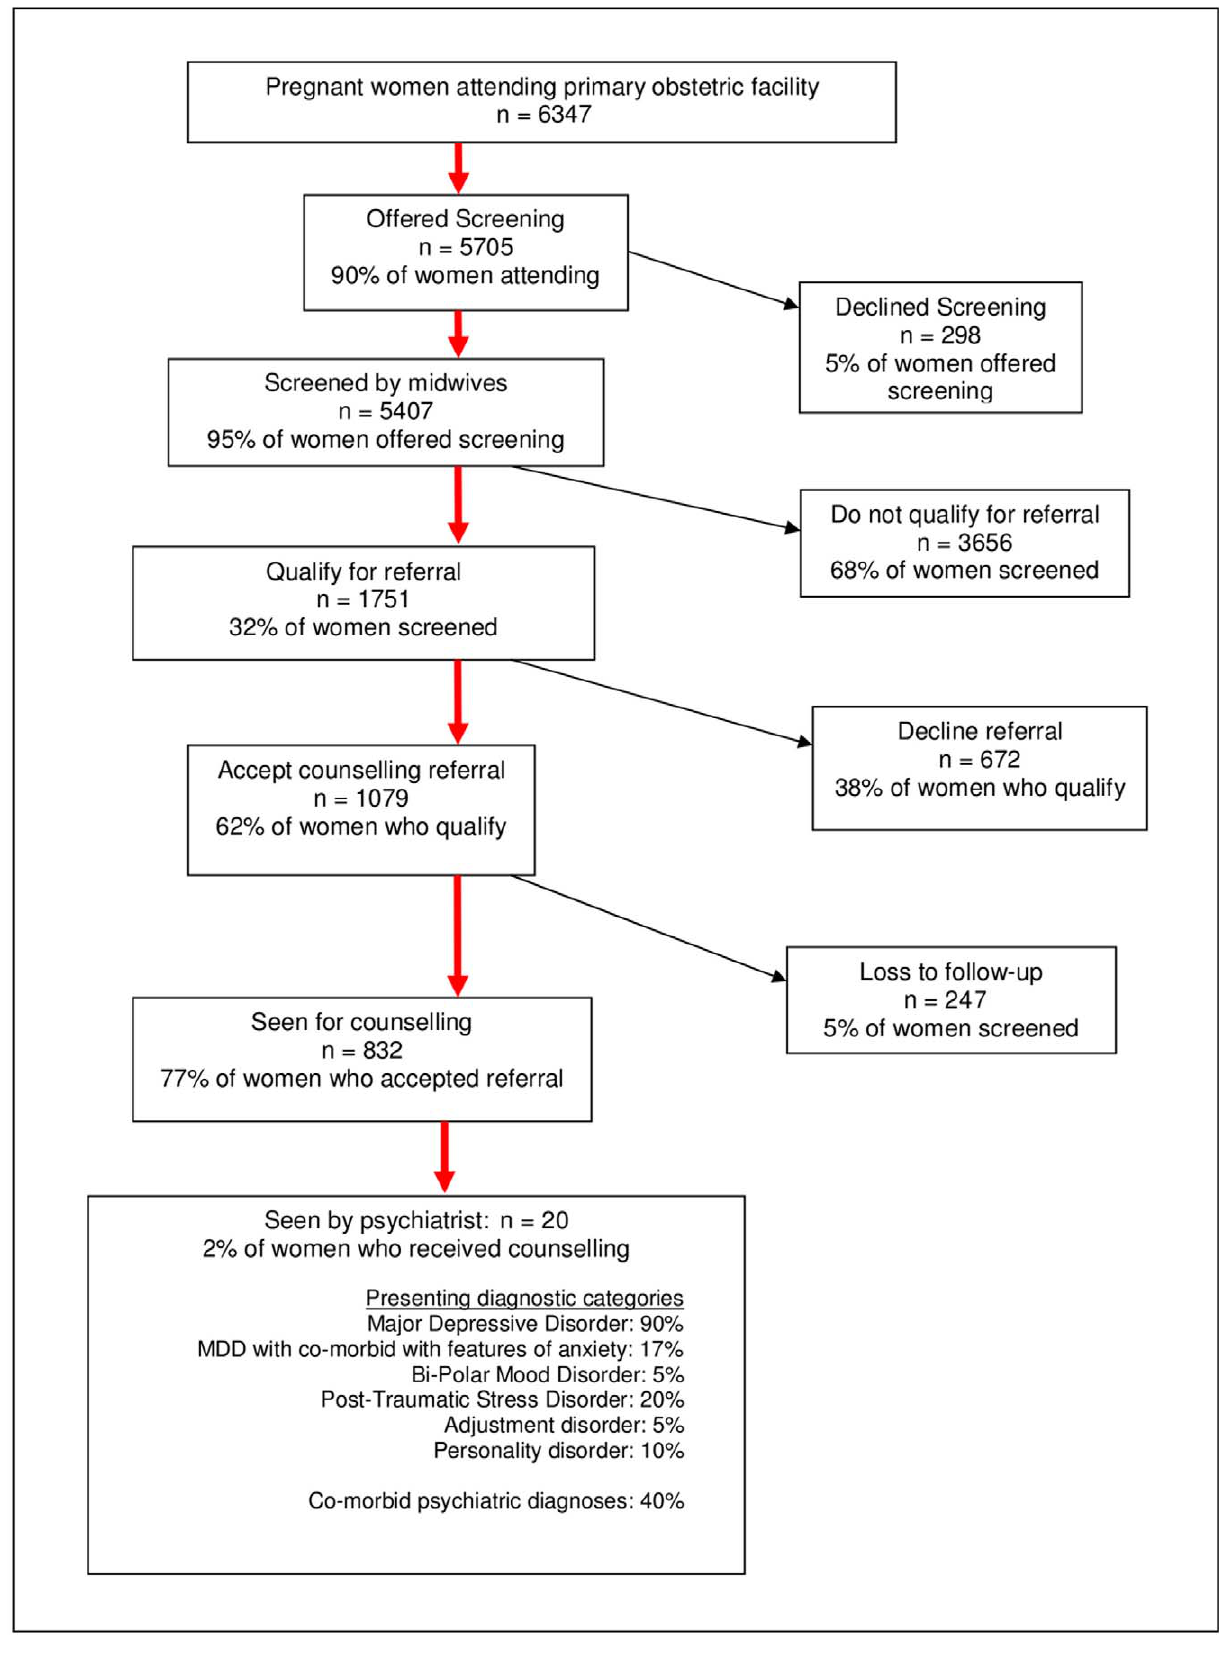
Figure 1. Screening coverage and pattern of service use from 01 July 2008–30 June 2011. doi:10.1371/journal.pmed.1001222.g001 PLoS Medicine |